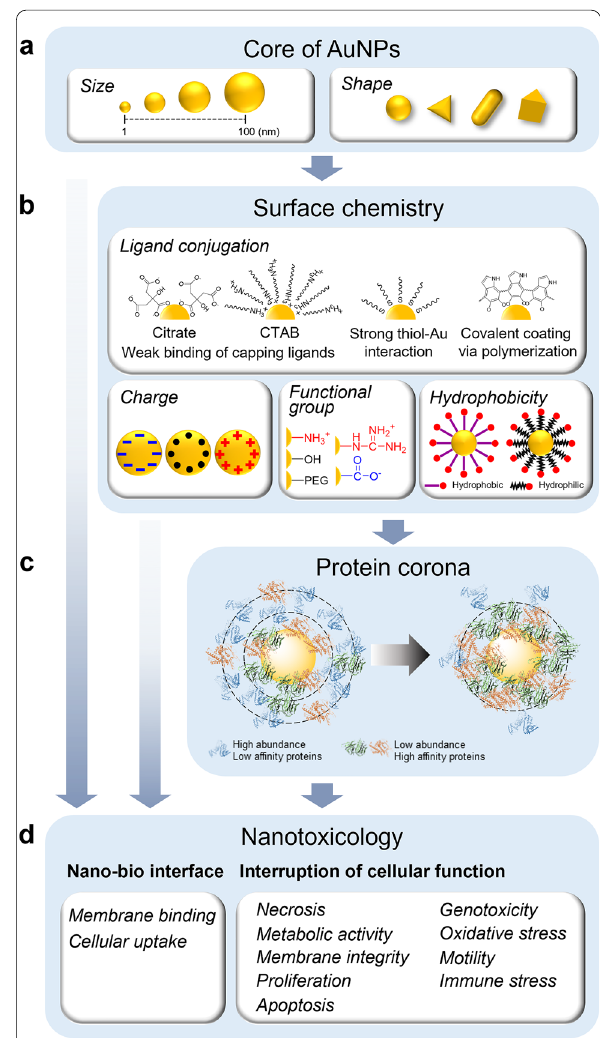
Fig. 1 Physicochemical parameters of AuNPs assessed in nanotoxicity studies. a Core size and structure; b surface chemistry; c protein corona; d